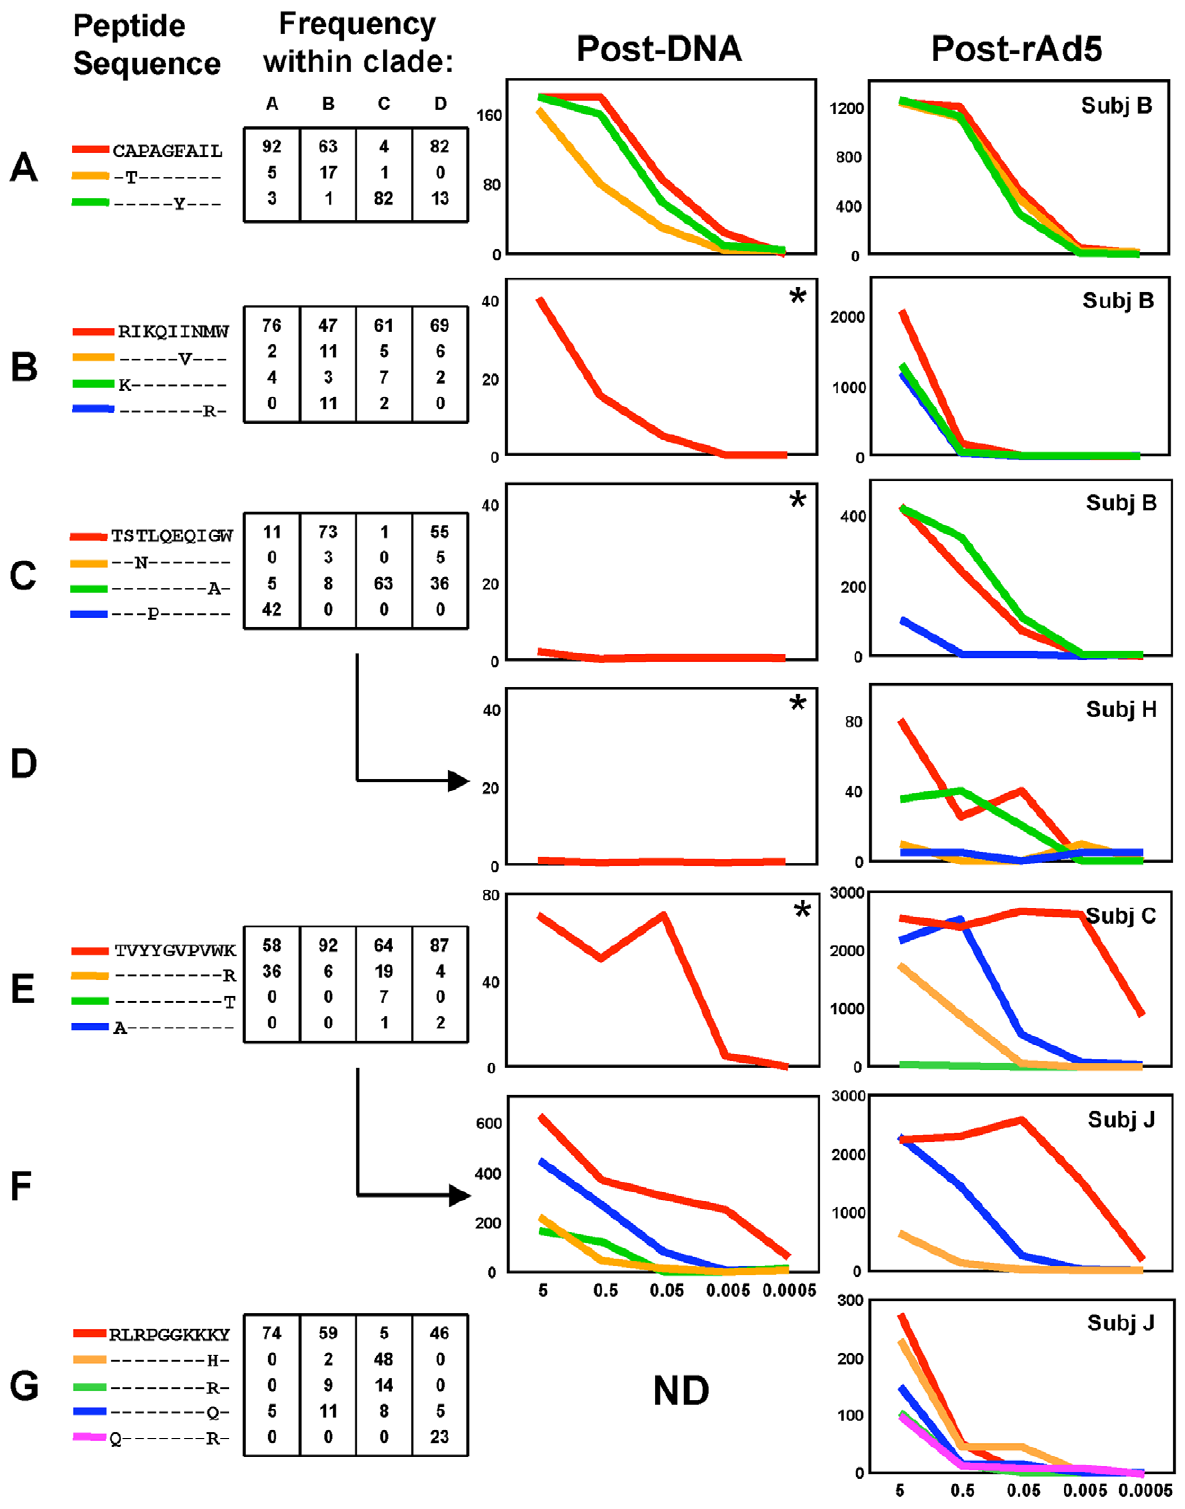
Figure 5. Clade coverage of epitope-specific responses. Seven responses (A through G) to five minimum CD8 + T cell epitopes as defined in Table 2 are shown for four VRC 009 volunteers. Volunteer identifiers are shown in far right panels. Left panel shows the minimum epitope and sequence variants that were tested. Left center panel shows the frequency of each variant as it occurs within HIV clades A, B, C, and D. ELISpot responses expressed as SFCs per million PBMC at multiple peptide dilutions ( m g/ml) to the epitope variants are shown from 4 weeks after the third dose of DNA (right center panel) and 4 weeks after rAd boost (far right panel). * = only the major variant was tested due to cell limitations. ND = not done due to absence of cells for any peptide titrations.